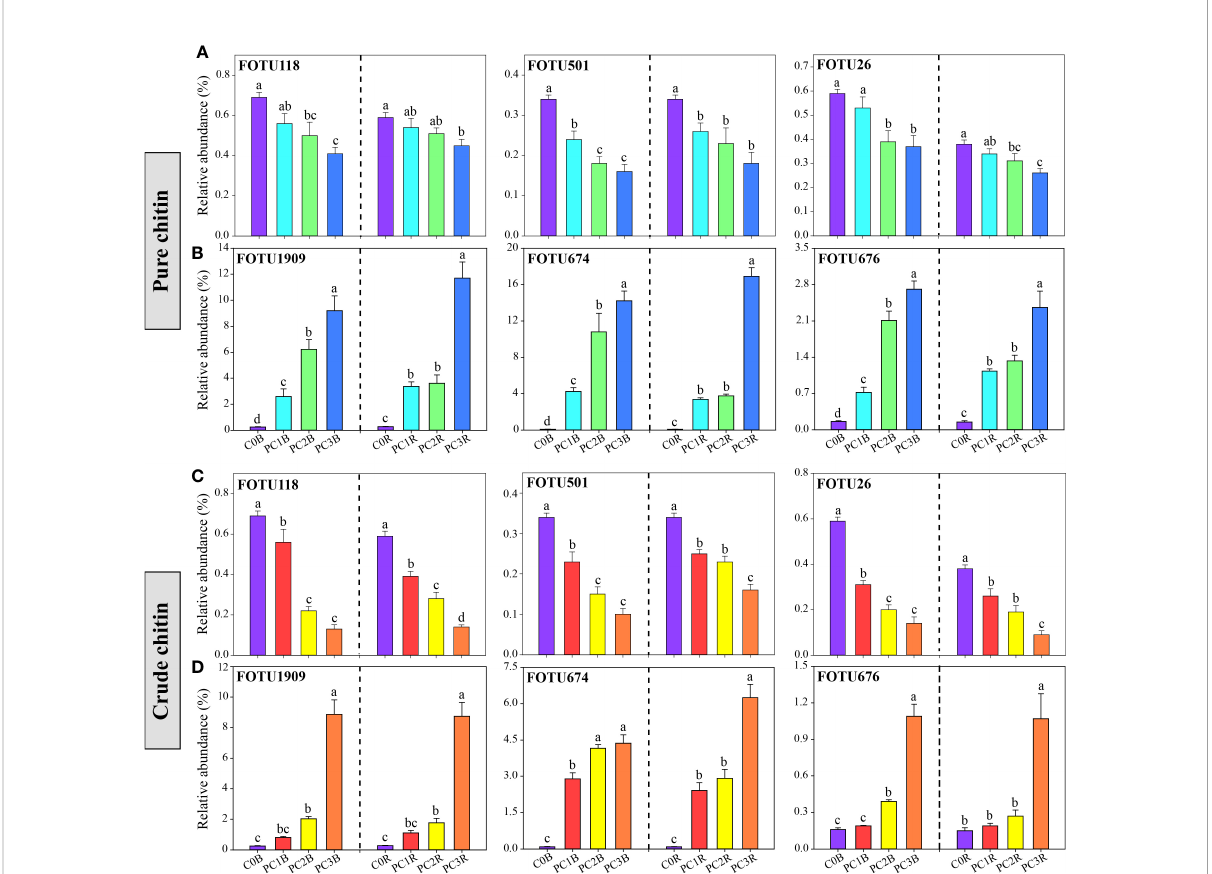
FIGURE 4 Relative abundance of potentially pathogenic (A, C) and bene fi cial (B, D) fungi under different pure and crude chitin addition dosages. The bars indicate the means of 8 replicates and the error bars represent the standard deviation. Different letters indicate signi fi cant differences among treatments (one-way ANOVA, P< 0.05, Duncan ’ s multiple-range test). The treatment description is same as Figure